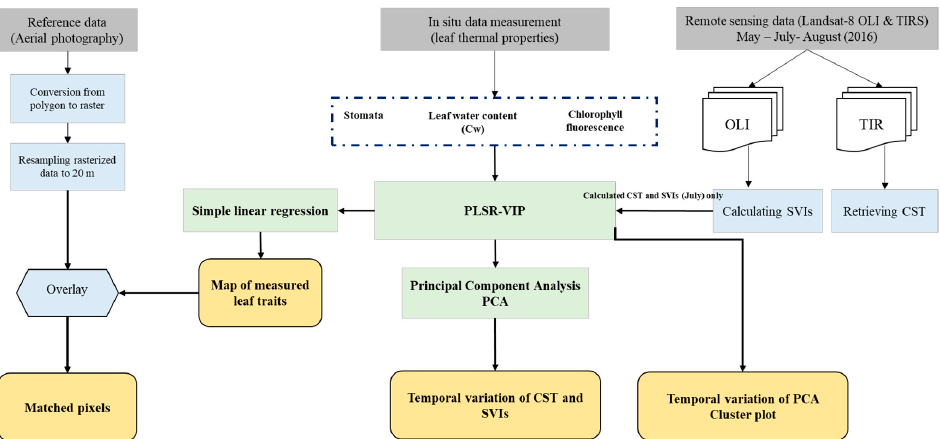
Figure 3. The framework of the research methodology.